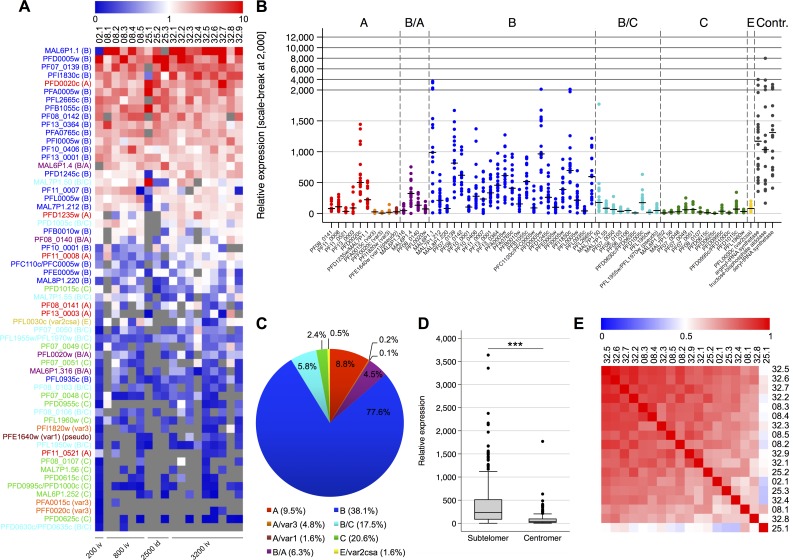

Var transcription profiles of parasites recovered from infected volunteers at the day of first microscopically detectable parasitemia.(A) Heat map showing the individual var gene expression for all volunteer samples taken when parasites were present in the thick blood smear ranked by mean expression. To correct for individual differences in the overall var expression levels, the expression for each var gene was normalized against the total var expression in each sample. The color scale indicates the relative expression levels with red representing values above the median, blue representing values below the median, and white representing median. Grey means not detected. The number of sporozoites (200, 800, 2500 and 3200) and mode of injection (iv = intravenous, id = intradermal) used for each volunteer are indicated below. (B) The distribution of the relative gene expression per var gene and control genes is shown in a dot plot for all volunteer samples at the day of patent infection defined as parasites present in the thick blood smear (n = 18). Each point represents a var gene expression value relative to the normalizing gene sbp1 observed per volunteer sample and the median expression per var gene is marked. Housekeeping genes used as controls, var gene names and groups are indicated. (C) Proportion of var gene expression by group across all volunteers at the day of patent infection. For comparison, genomic proportion of each var gene group is indicated after the color code. (D) Comparison of the expression levels between subtelomeric and centromeric var gene variants. The box plot shows the distribution of transcript levels for each individual var gene relative to sbp1 according to the chromosomal localization of the genes for all 18 volunteer samples at the day of patent infection. Gene expression varied significantly between both gene sets (Wilcoxon rank-sum test, p<0.0001) with median expression of 232 (IQR: 87–510) for telomeric var genes and 40 (IQR: 18–94) for centromeric var genes. (E) The heat map of pairwise Spearman’s rank correlation coefficients (R) between expression profiles illustrates the positive correlation between all 18 volunteer samples at the day of patent infection. Volunteer samples were ranked by the sum of their correlation coefficients. The color scale indicates the correlation coefficient in the range from 0 to 1. With exception of isolate 25.1 versus the isolates 02.1 (p = 0.0015), 25.3 (p = 0.0029) and 32.4 (p = 0.0030) all expressions correlated at a significance level below 0.001.